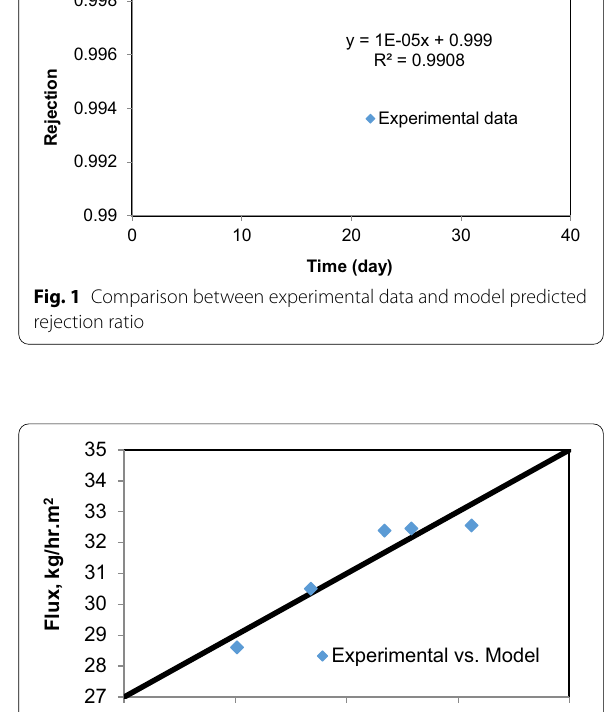
R = ( 1 E − 5 ) x + 0.999